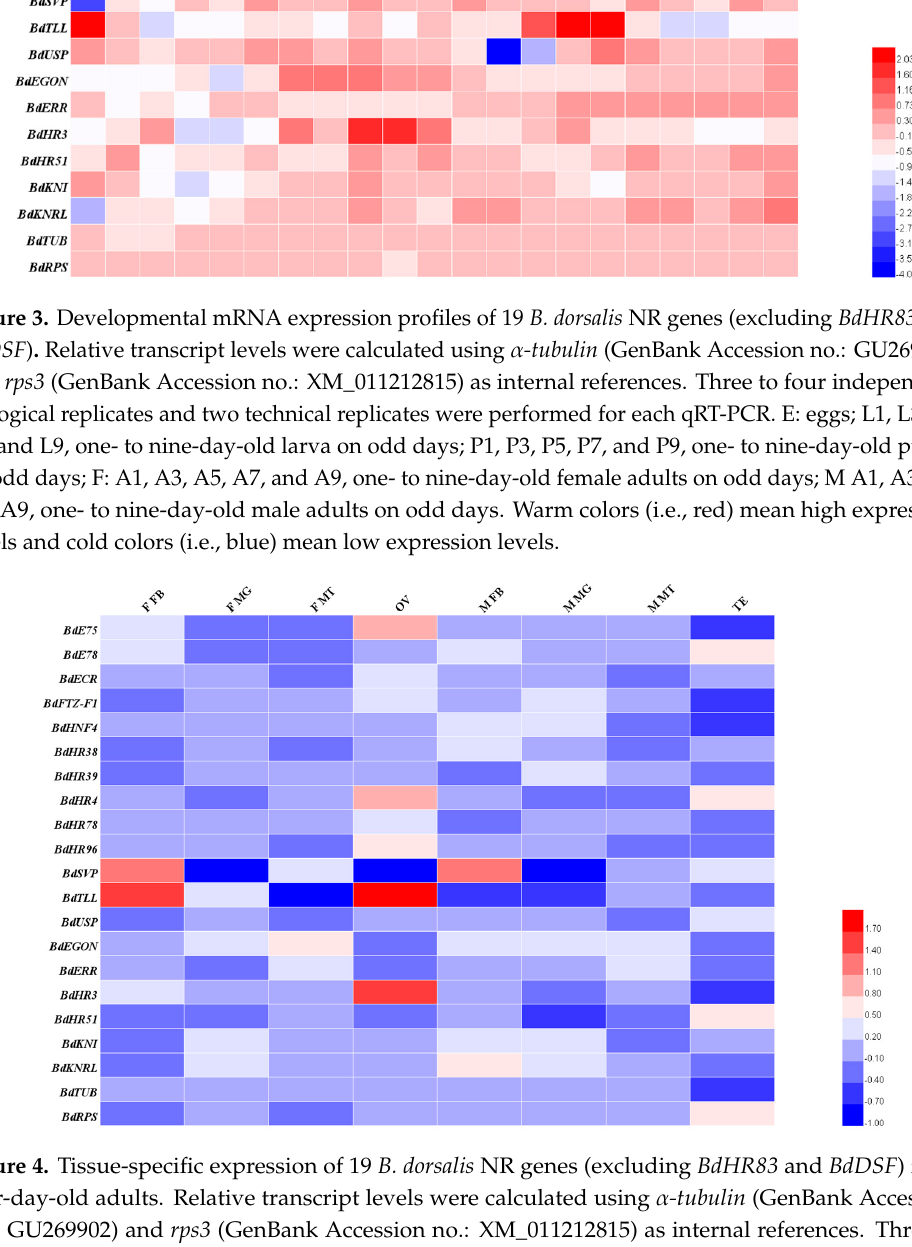
Figure 5. Tissue-specific expression of 19 NR B. dorsalis genes (excluding BdHR83 and BdDSF ) from third instar larvae. Relative transcript levels were calculated using α -tubulin (GenBank Accession no.: GU269902) and rps3 (GenBank Accession no.: XM_011212815) as internal references. Three to four